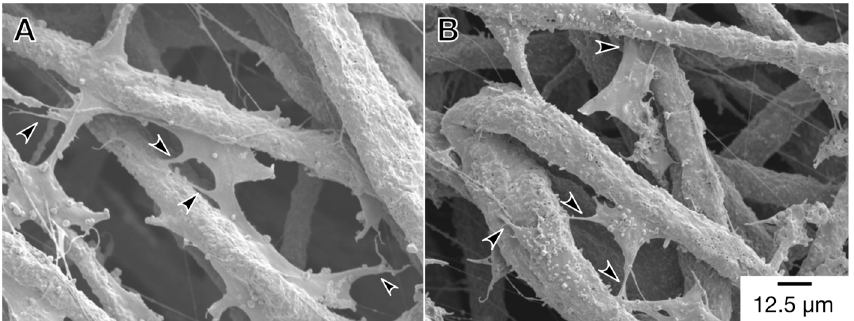
Figure 4. Morphological observation of ( A ) monoculture and ( B ) co-culture cells by SEM. Cells were seeded at 5.0 × 10 4 cells cm –3 on a microfiber mesh scaffold placed in each well of a 24-well plate and cultured for five days. At the culture time, the cells were fixed and viewed with SEM at 800× magnifications (scale bar: 12.5 µ m). Arrowheads show pseudopodium-like structures.